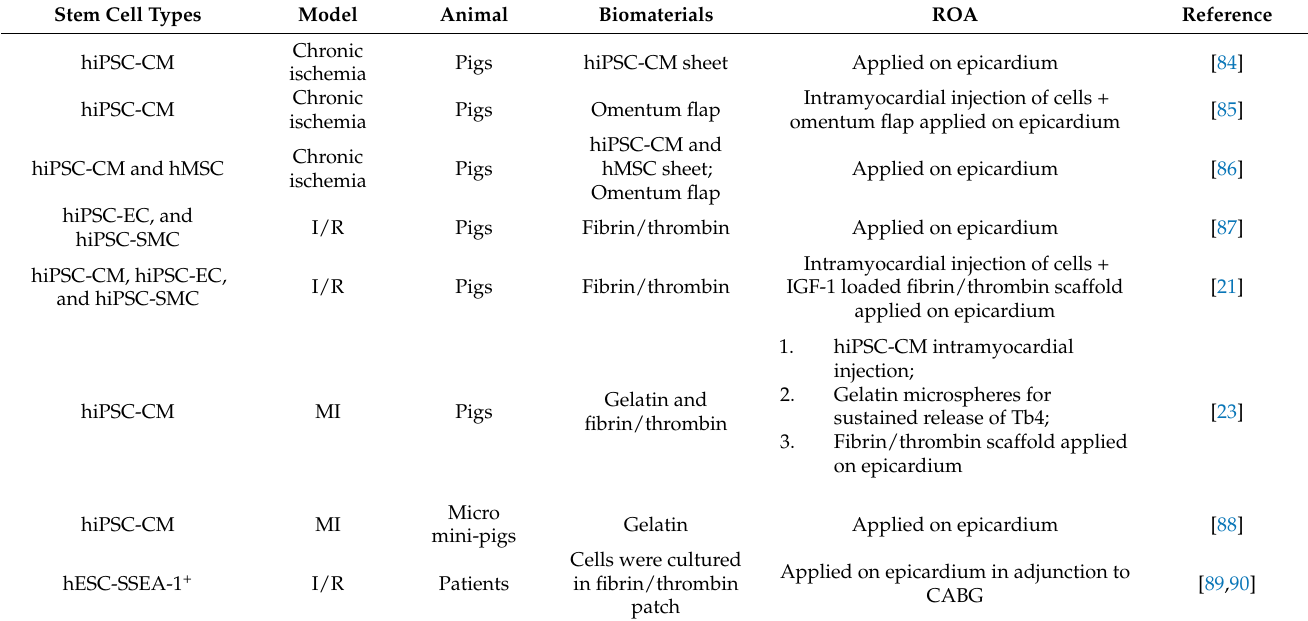
Table 3. Tissue engineering using PSC derived cardiovascular cells for treatment of MI in large animal models and